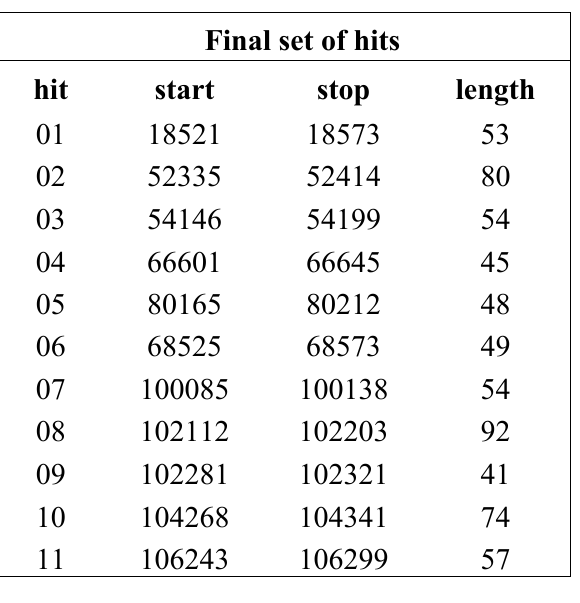
Table 3. The final set of highly conserved sequences (hits) and the positions within the Myxoma virus